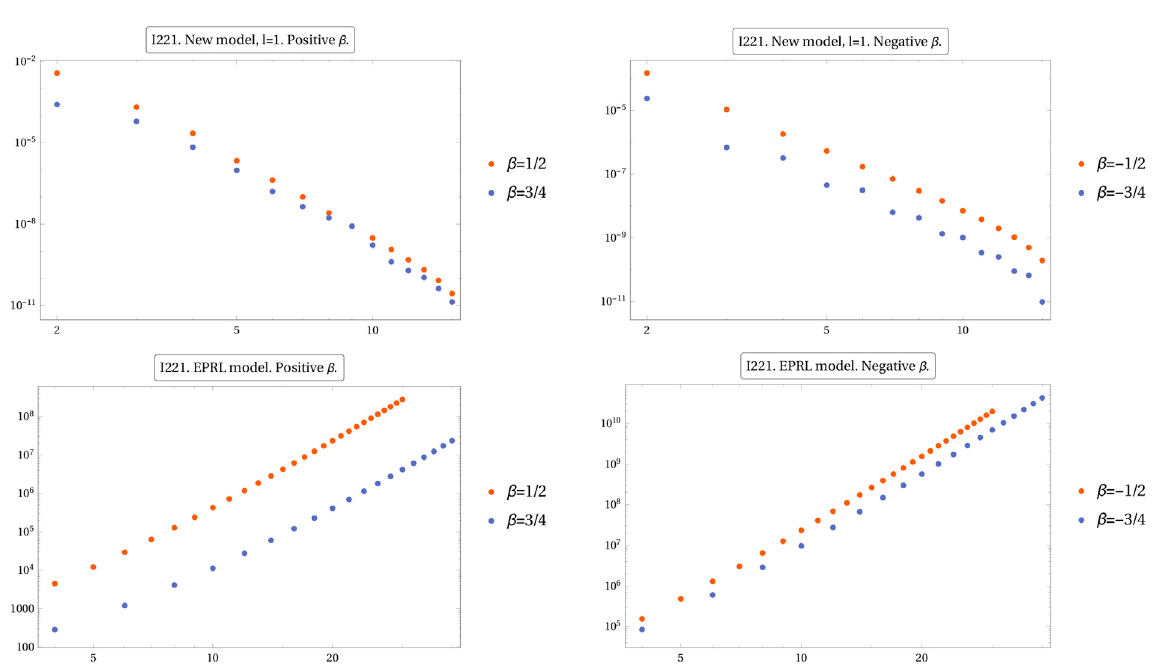
TABLE 2 | Top: numerical evaluation of the expression I 221 ( Λ max ) − I 221 ( Λ ) as a function of the cutoff Λ ∈ [ 2 , 16 ] in a Log-Log scale for different values of β . Here I 221 is given by the master integral (3.15). Bottom: numerical evaluation of the EPRL model ’ s master integral (3.16) as a function of the cutoff Λ and β . The cutoff ranges